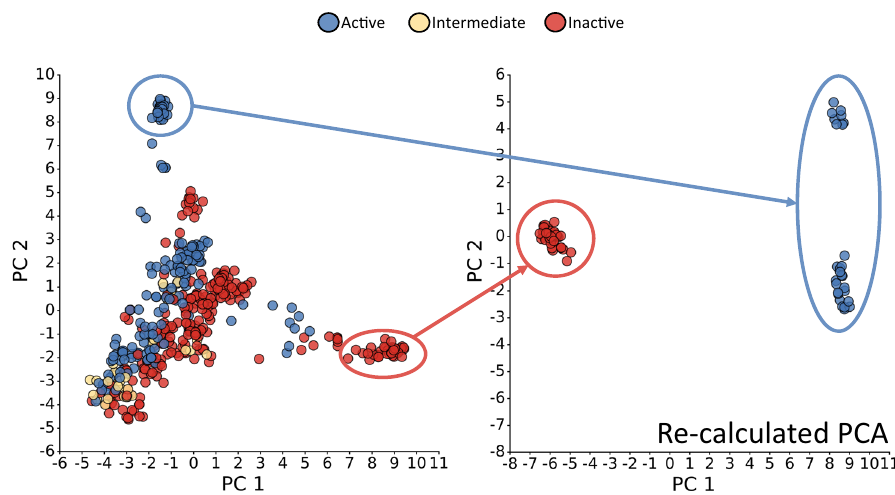
Fig. 2 Plot of the fi rst two principal components (PCs) of the residue contact analysis for class A structures. Each point represents a PDB structure. They are coloured according to the GPCRdb classi fi cation into active (blue), intermediate (yellow), and inactive (red) 16 . The right panel shows the data re- calculated based on the points in the clearly separated active and inactive clusters. Each principal component (PC) value for each PDB can be seen as a linear combination of variables (i.e. contacts) that represents the residue contact landscape of a structure in a condensed manner. The fi rst two PCs shown here explained most of the variance across all structural data, hence represent the most interesting PCs for investigating differences between receptor states on the residue contact level. Source data are provided as a source_data.xlsx fi